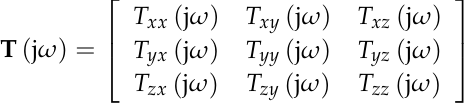
Figure 3. Imaginary parts and coherences of the TFRFs derived from the 12 output signals when the system was hit in the Z direction at the different points of Figure 1c. F (cid:48) cell reference frame. From ( a ) to ( l ), all the TFRFs W qp with q = 1, . . . ,12 and p = 11, . . . ,16 (i.e., with inputs along the Z direction) are